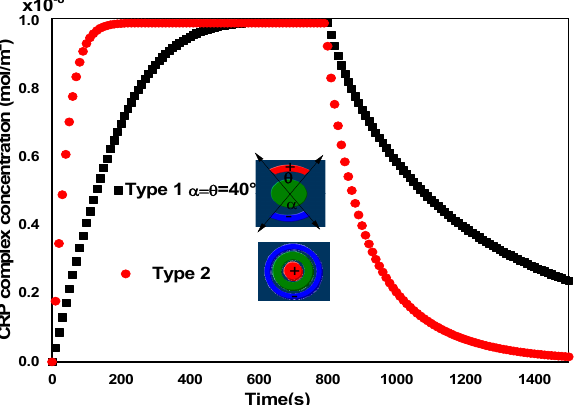
Figure 4. Temporal evolution of the average surface concentration of CRP complex for the two types of biosensors for V rms = 15 V. For the first model, the electrodes angles ( θ , α ) are fixed to 40°. The average inlet velocity is fixed at 100 μ m/s.